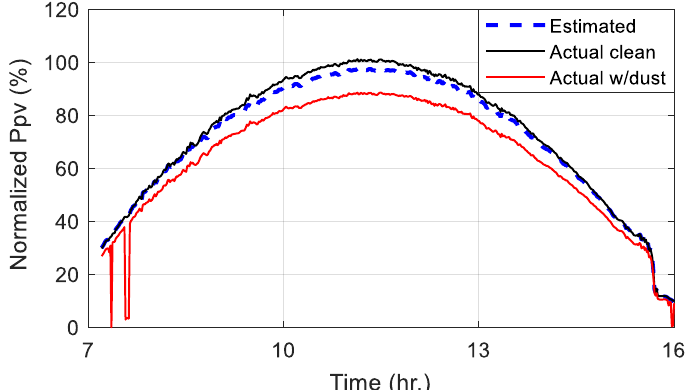
Figure 16. Estimated and actual PV output power during a sunny day.